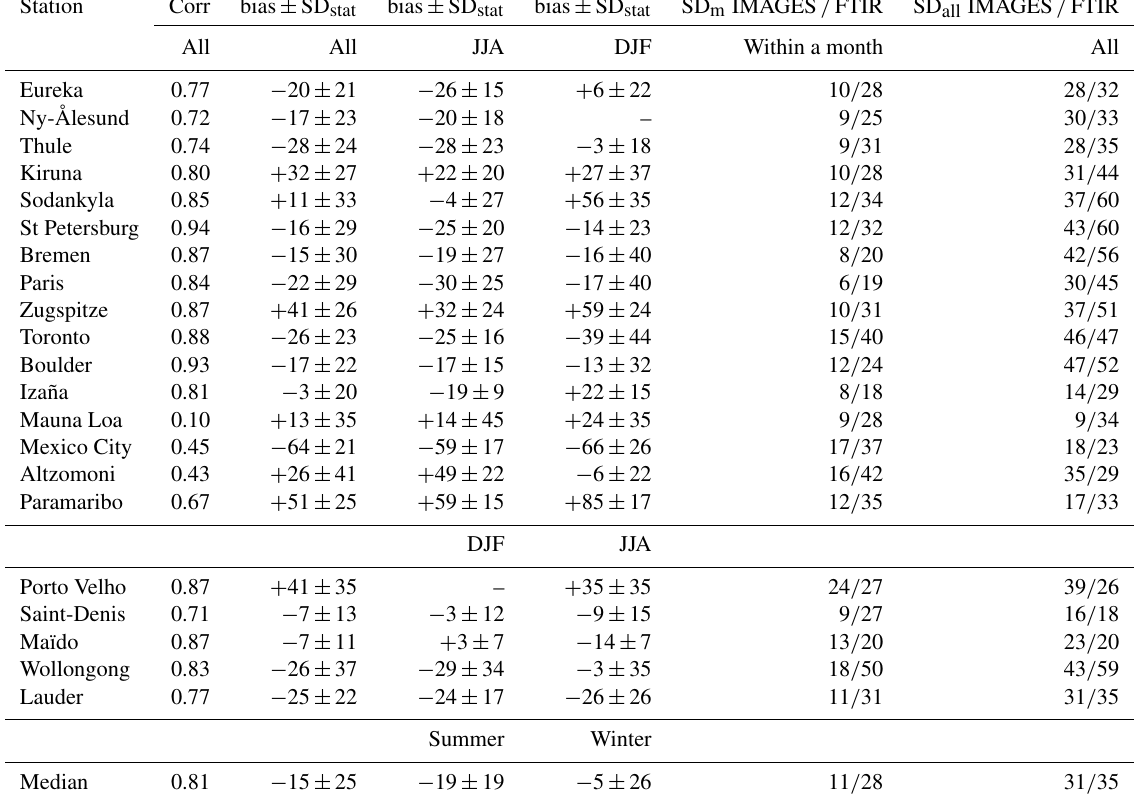
Table 4. Correlation (Corr), bias ± standard deviation (SD stat ) of the statistical comparisons between the monthly means, mean ( IMAGES ( smoothed ) − FTIR )/ mean ( FTIR ) . Also given are the mean of the standard deviations in the IMAGES and the FTIR monthly means, i.e. the variability within a month (SD m ), and the standard deviation of the whole FTIR and IMAGES monthly mean time series (SD all ). All numbers, except the correlations, are given in